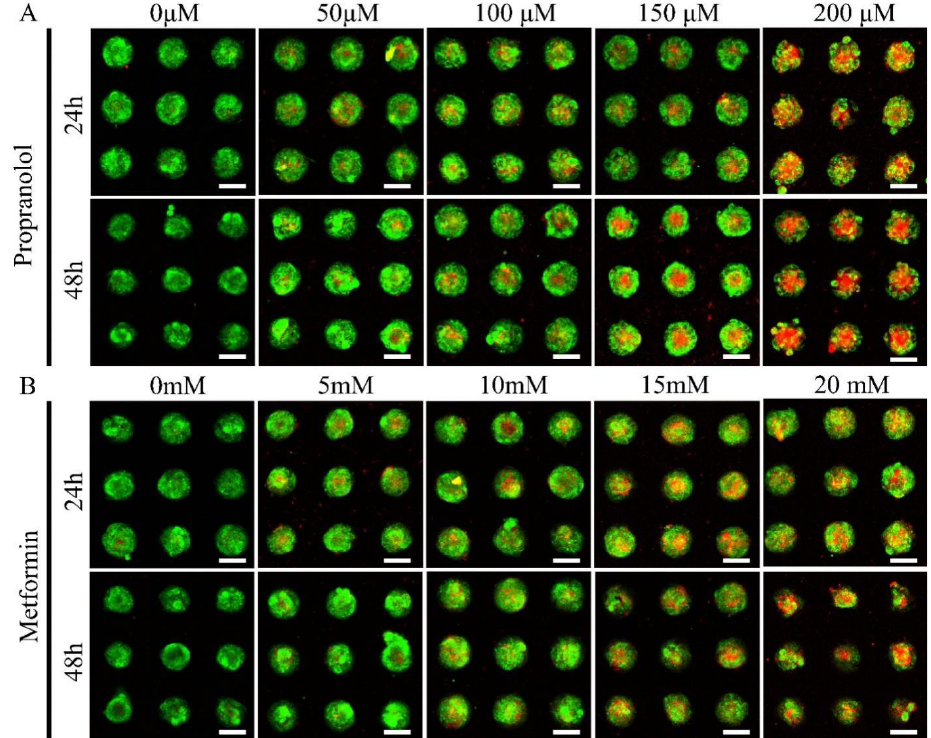
Figure 7. Drug screening of propranolol ( A ) and metformin ( B ) in CD31+ HemEC microtumors with live/dead staining. Scale bars = 100 μm.